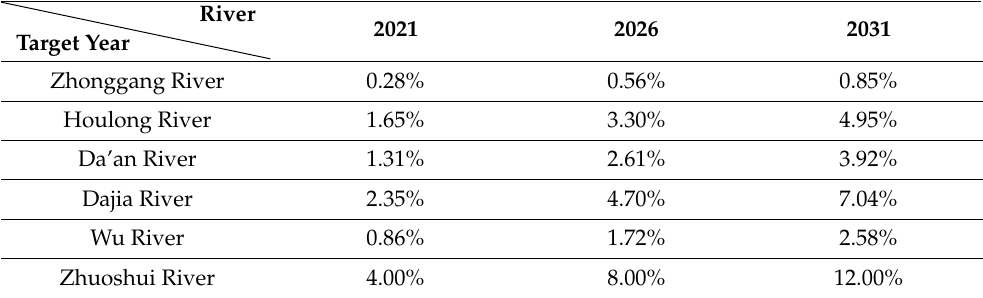
Table 5. Ratio of Reduction in Surface Water in Each Area of Central Taiwan Due to Climate